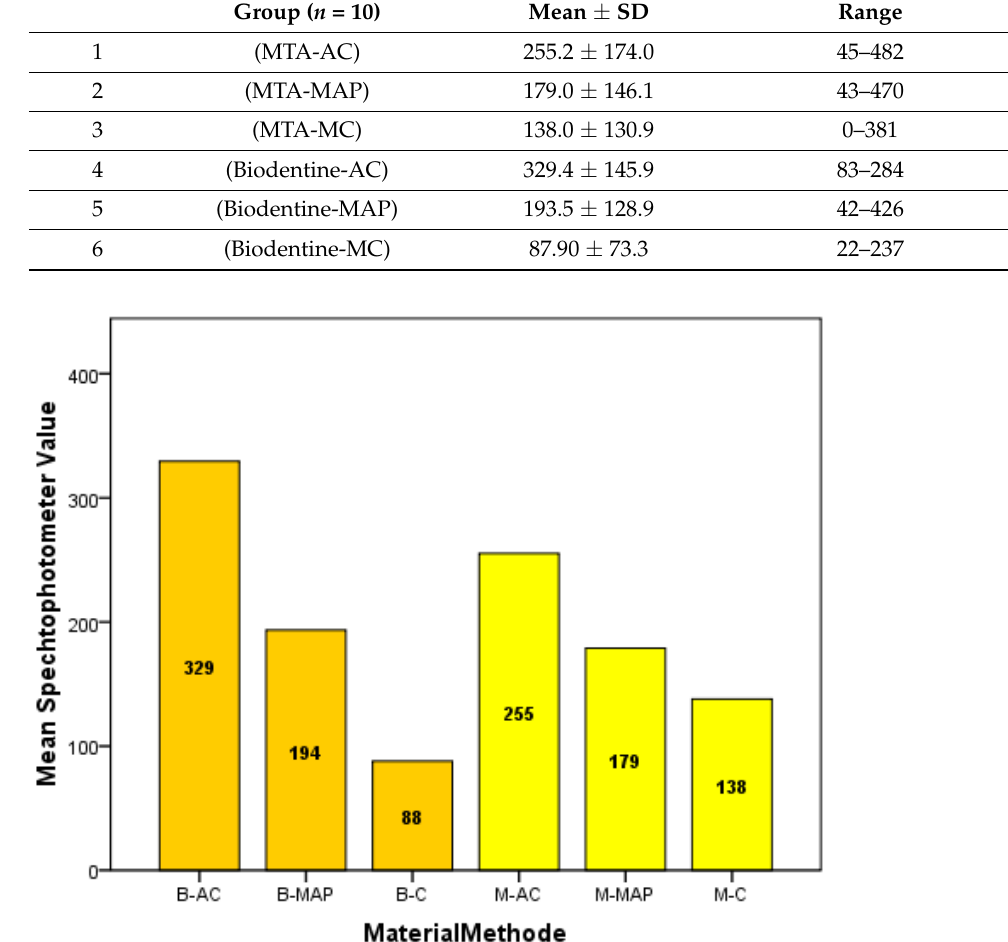
Figure 4. Mean spectrophotometer values.